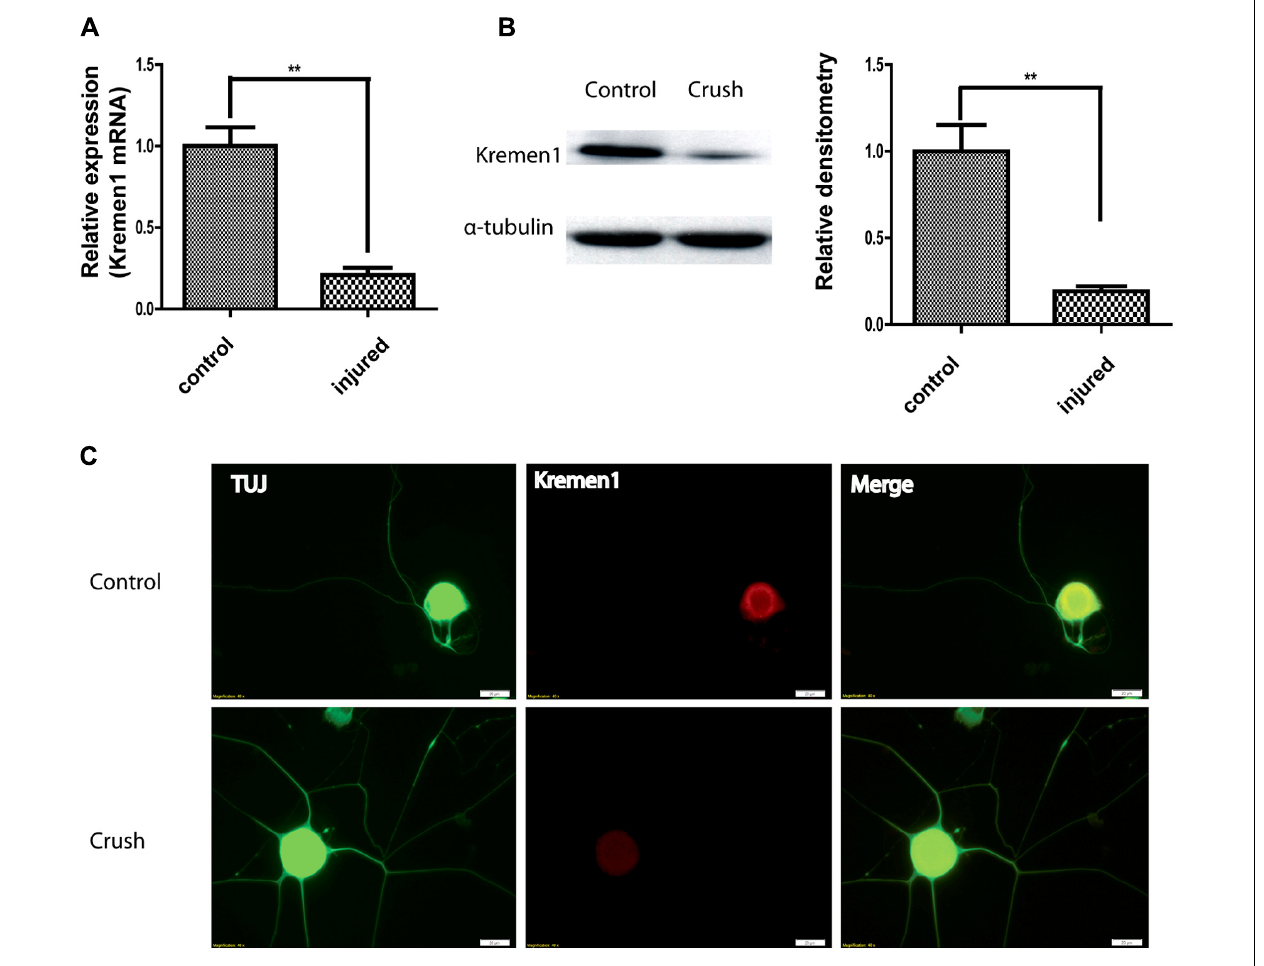
FIGURE 4 | Nerve crush injury reduces Kremen1 expression. (A) Total RNA was isolated from control or crush-injured mouse DRG, and relative expression of Kremen1 was determined using RT-qPCR. GAPDH and S12 were used to normalize for RNA loading. (B) Western blot analysis of total DRG lysates at 4 days post-crush injury. α -Tubulin was shown as a loading control. As shown in the quantified densitometry data, there was a significant decrease of Kremen1 expression during nerve regeneration.